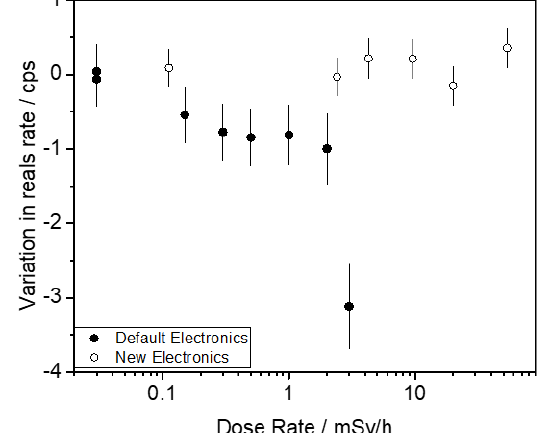
Fig. 5. Change in the reals count rate without 252 Cf source as a function of the dose for the system with the default and new